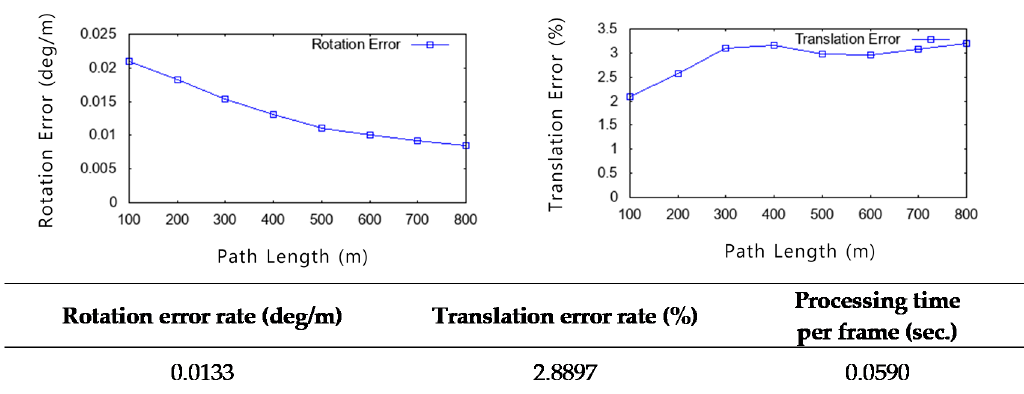
Figure 21. Graph of error over mileage for sequence 07.